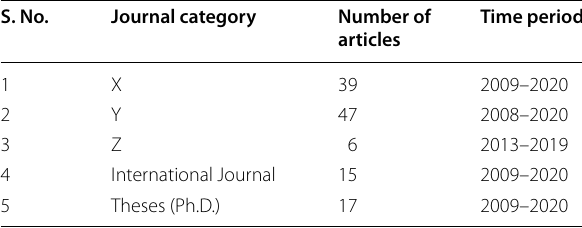
Table 9 Descriptive details of reviewed articles/theses S.